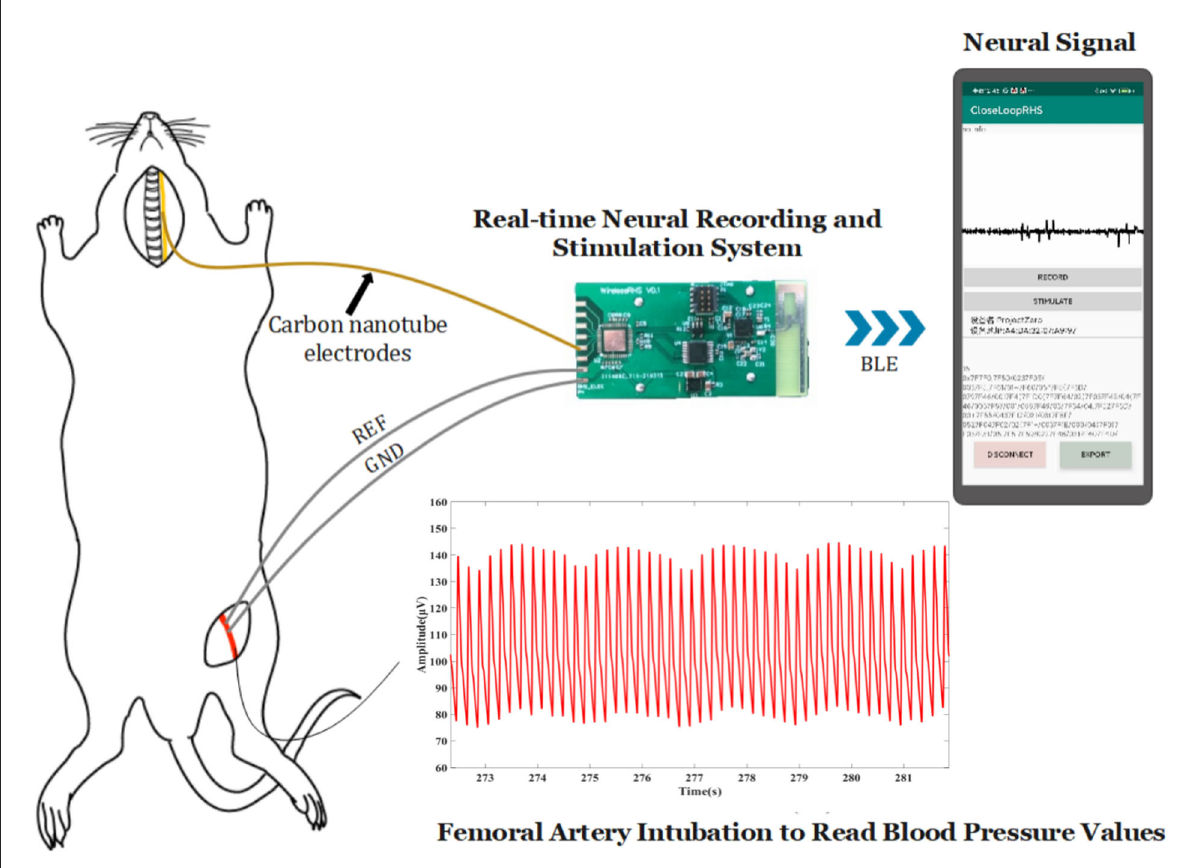
FIGURE5 Actual study